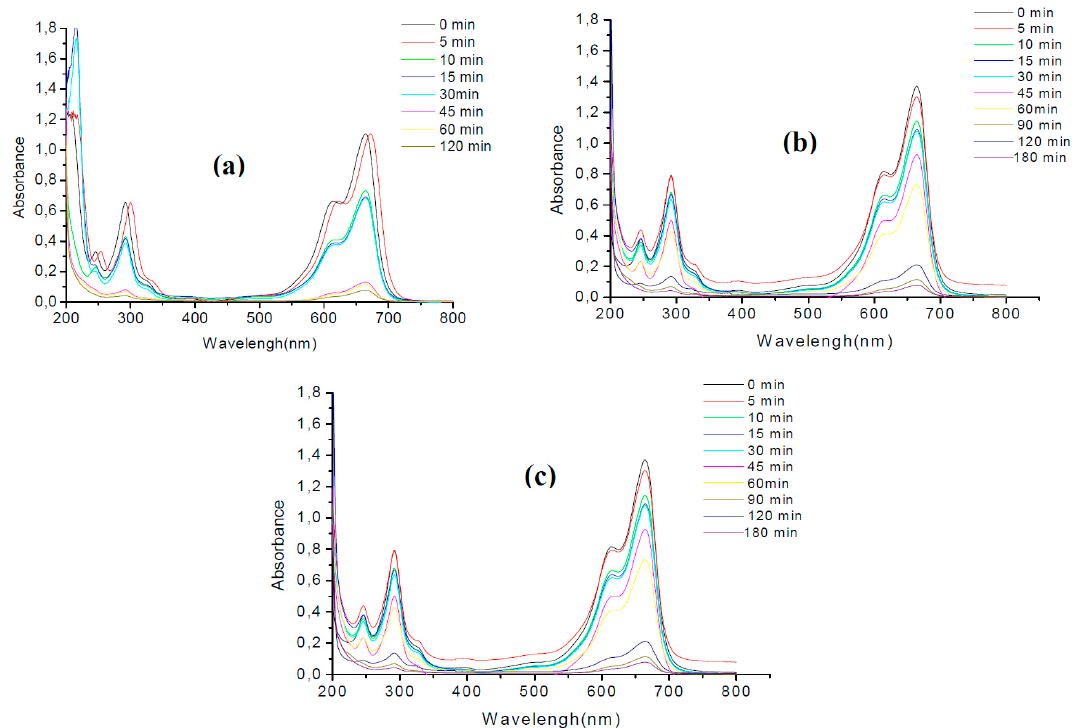
Figure 5. spectra of MB biosorpion assisted by AC using (a) hybrid material L.C + 4% Zn 2+ synthesized Figure 5. Spectra of MB biosorpion assisted by AC using ( a ) hybrid material L.C + 4% Zn 2 + synthesized in presence of AC, ( b ) hybrid material L.C + 4% Zn 2+ synthesized in absence of AC and ( c ) pure L.C , in presence of AC, ( b ) hybrid material L.C + 4% Zn 2 + synthesized in absence of AC and ( c ) pure L.C , C i = 10 mg / L, pH = 10, m = 0.1g, V = 0.1 L, T = 298 C i = 10 mg/L, pH = 10 ,m L.C = 0.1g, V = 0.1 L,T = 298 K . L.C